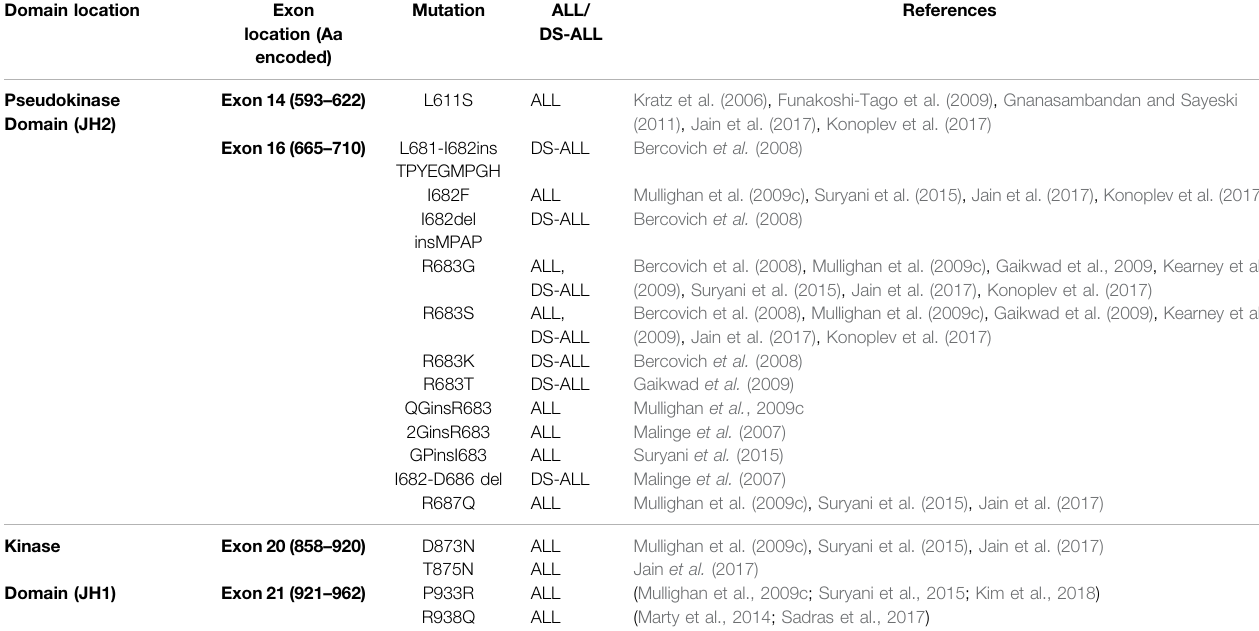
TABLE 2 | All reported JAK2 mutations in patients with ALL. The majority of mutations reported in ALL and DS-ALL localize to JAK2 exon 14 or 16, encoding the JAK2 pseudokinase domain (JH2). Some mutations have also been reported to localize to JAK2 exon 20 or 21, encoding the JAK2 kinase domain (JH1). Amino acids (aa.) encoded by each JAK2 exon are